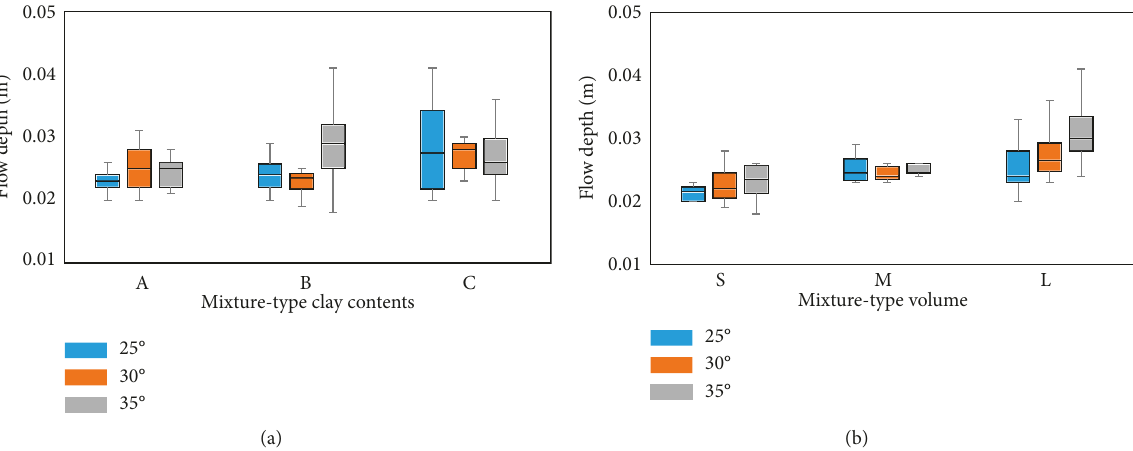
Figure 3: The change of flow depth according to clay contents (a) and mixture volume (b) as slope condition changes.